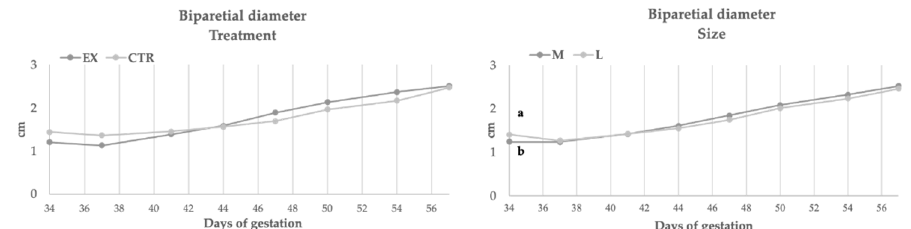
Figure 3. Biparietal diameter during gestation in function of diets and size. EX: experimental group CTR: control group; a, b: p < 0.05.